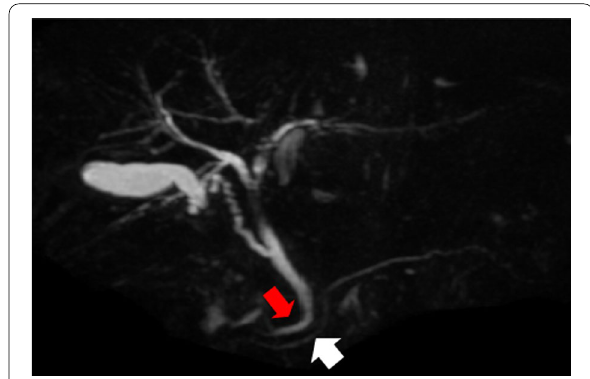
Fig. 3 Magnetic resonance cholangiopancreatography image. The CBD (red arrow) exhibits a hook-like configuration. Separate opening between the CBD and pancreatic duct (white arrow)